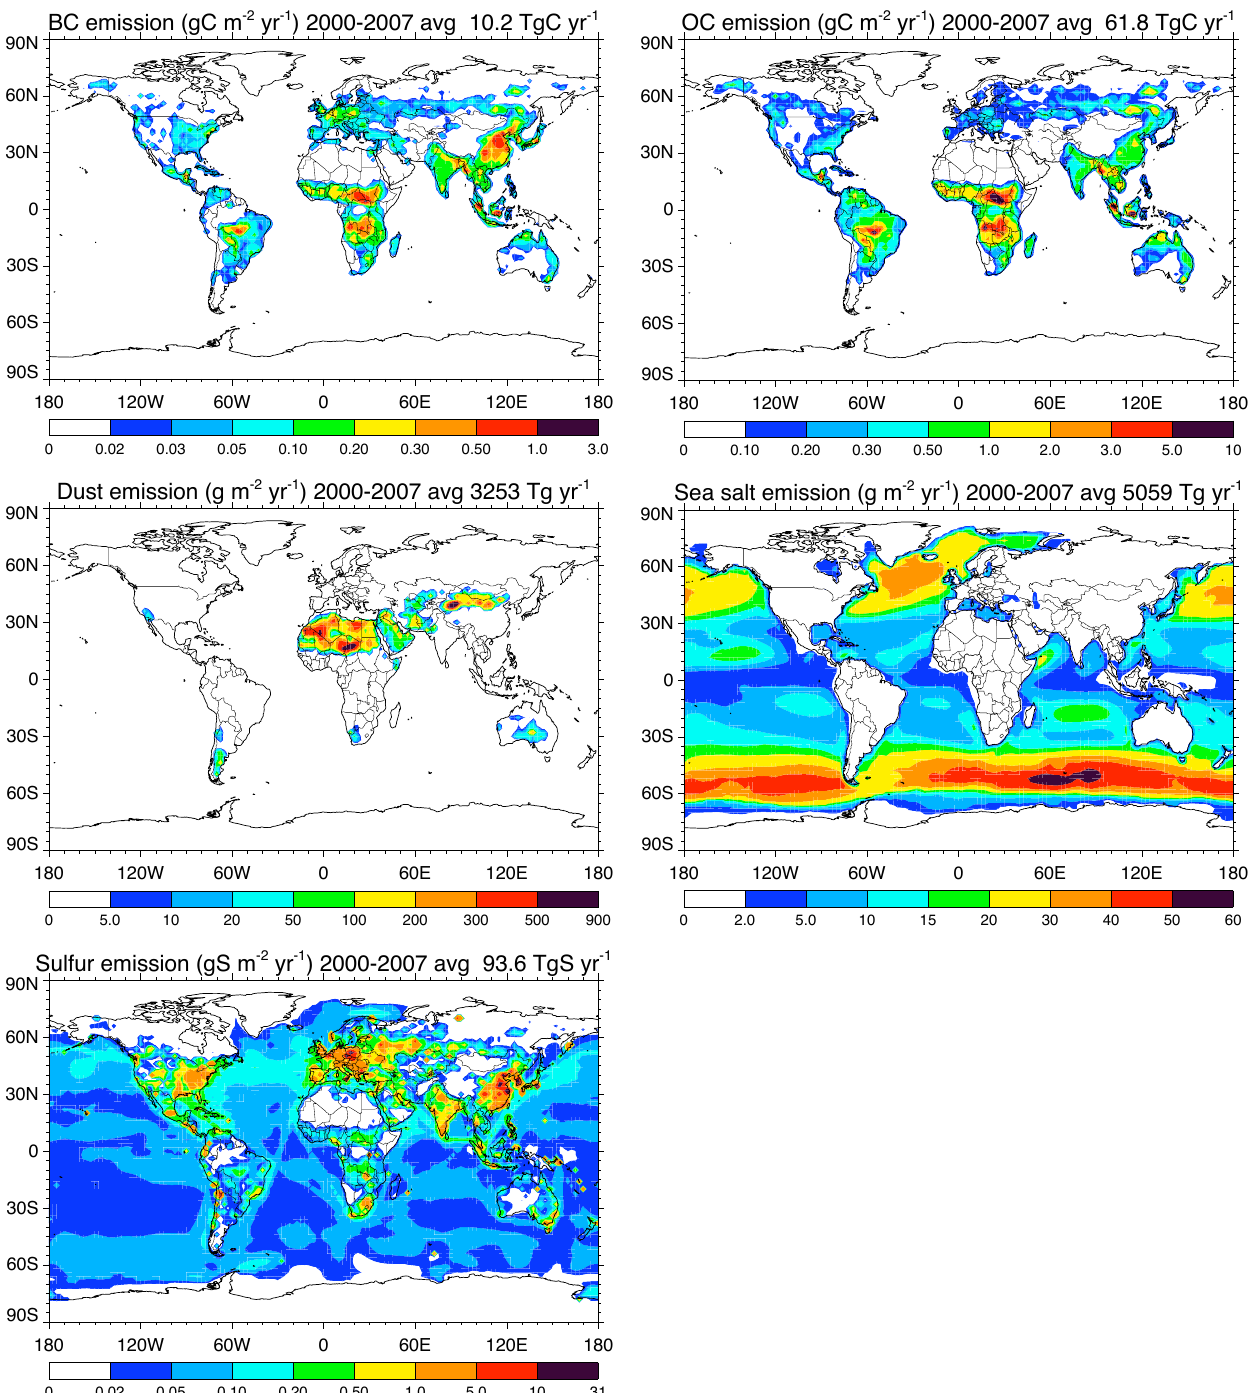
Fig. 2. 8-year (2000–2007) averaged emission rates of BC, OC, dust, sea salt, and sulfur from all (including anthropogenic, biogenic, volcanic, biomass burning, and oceanic) sources. Emission of sulfur includes gaseous phase SO 2 and DMS and particulate sulfate emissions.